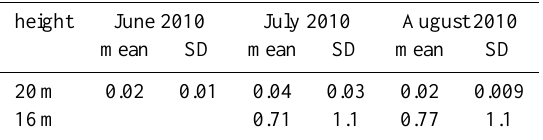
Table 5. Ambient total sesquiterpene concentrations were found only during summer months and at the upper part of the canopy. Values are given as mean and standard deviation (SD) in µg m − 3